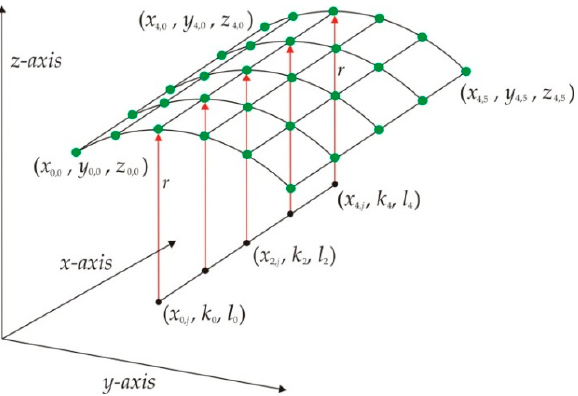
Figure 3. Rectangular cylindrical surface to perform cylindrical surface modeling.